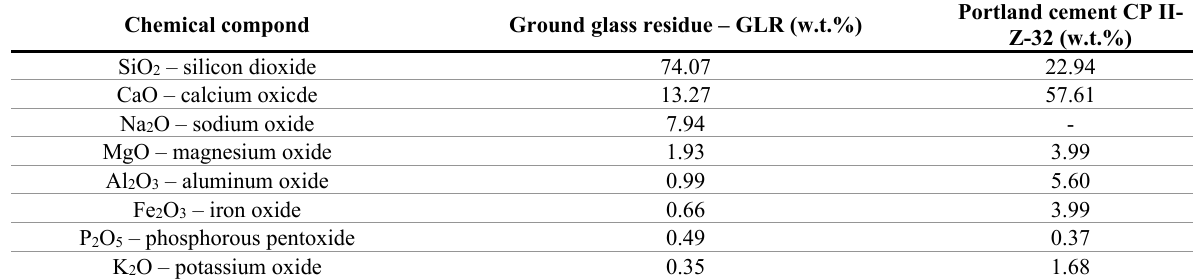
Table 4. Chemical composition of GLR and Portland cement CP II-Z-32 Chemical